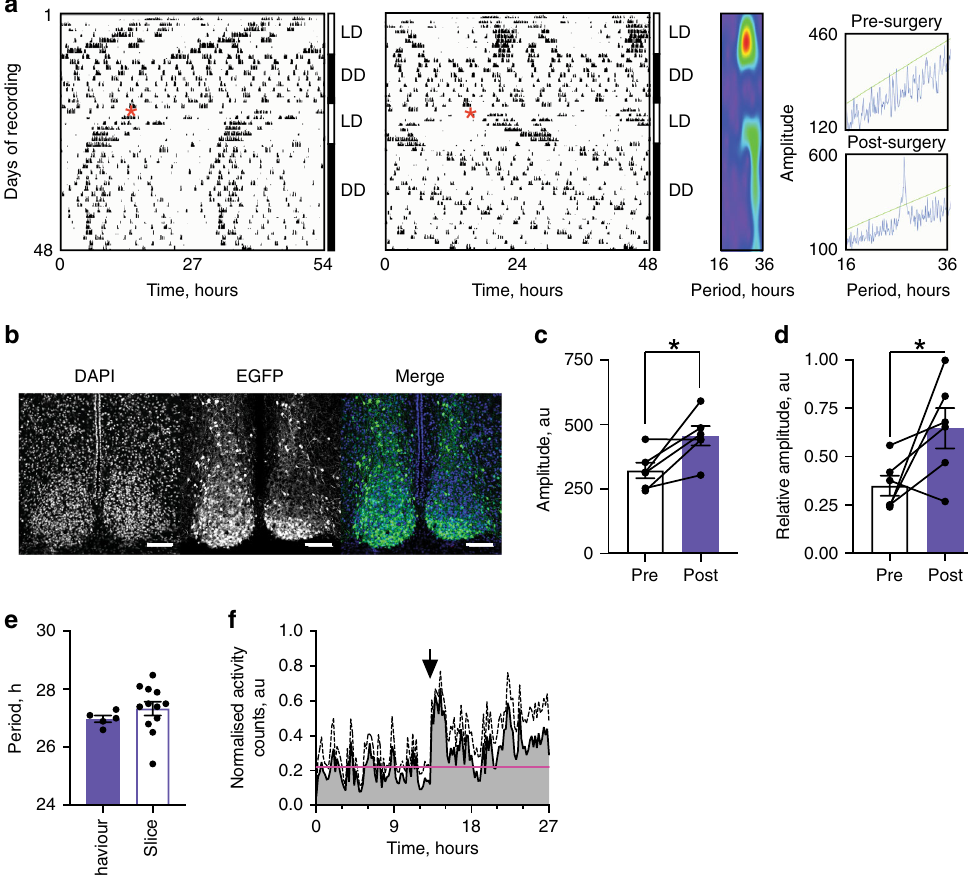
Fig. 8 Conditional Cry1 expression in the VIP-VPAC2 cellular axis is suf fi cient to initiate and sustain circadian behaviour. a Representative double plotted wheel-running traces on a 27-h time base (left) and a 24 h time base (right) showing the behaviour of a VIP;VPAC2 Cre Cry-null mouse pre- and post-surgery (indicated by a red asterisk). Wavelet analyses are shown to the right of the plot. b Representative confocal images from the SCN of the mouse in a showing Cry1::EGFP distribution across the core and shell of the SCN, showing DAPI (left), EGFP (middle) and a false colour merged image (right). Scale bar is 100 µ m. c Summary behavioural amplitude for VIP;VPAC2 Cre Cry-null mice pre- and post-surgery ( n = 6 mice) (* p = 0.011). d Summary behavioural relative amplitude for VIP;VPAC2 Cre Cry-null mice pre- and post-surgery ( n = 6 mice) (* p = 0.034). e Summary free-running periods for VIP;VPAC2 Cre Cry-null post-surgery plotted alongside the periods of initiated VIP;VPAC2 Cre Cry-null ex vivo SCN (replotted from Fig. 7b) ( n = 5 mice, 12 SCN). f Average normalised activity pro fi les for the last 7 days of recording post-surgery shown as mean + SEM. The activity of each mouse is aligned at activity onset (indicated by the black arrow), and the mean activity from the pre-surgery condition (subjected to the same relative alignment, shown in Supplementary Fig. 11b) is plotted as a horizontal line (pink) ( n = 5 mice). In all histograms individual points (paired/unpaired) represent individual mice/SCN slices; bars represent mean ± SEM. Statistics: c , d paired one-tailed t -test, e unpaired two-tailed t -test. Only signi fi cant comparisons ( p < 0.05) are shown. Source data are provided as a source data fi